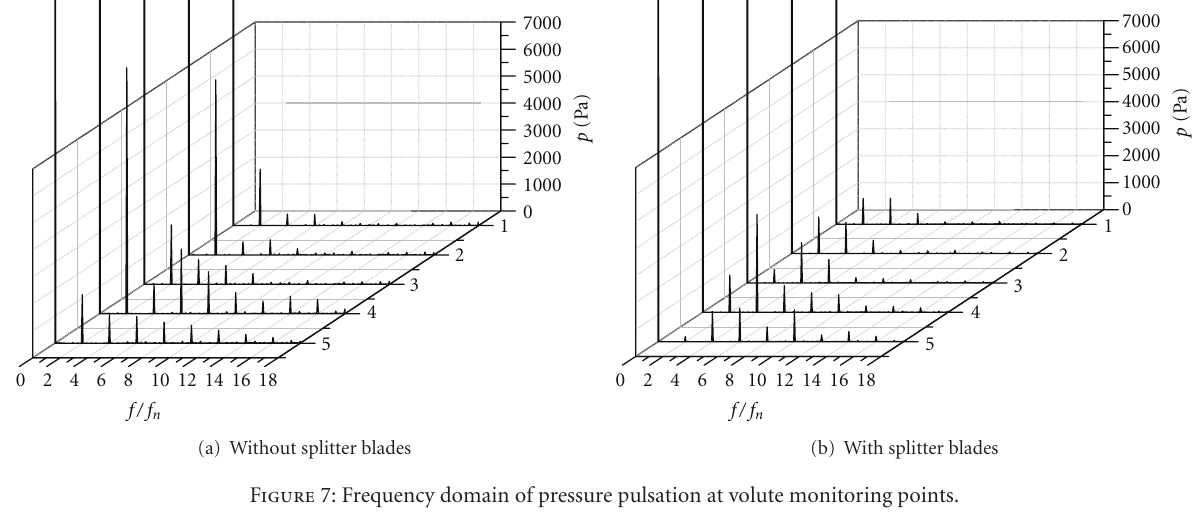
Figure 7: Frequency domain of pressure pulsation at volute monitoring points.